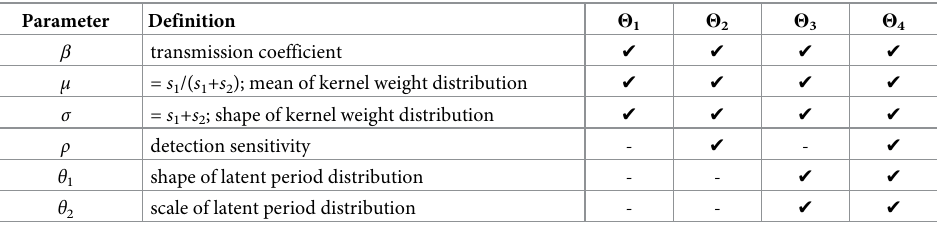
θ 1 shape of latent period distribution θ 2 scale of latent period distribution For each estimation scenario, the set of parameters to be estimated, Θ , comprises the parameters indicated with a ✔